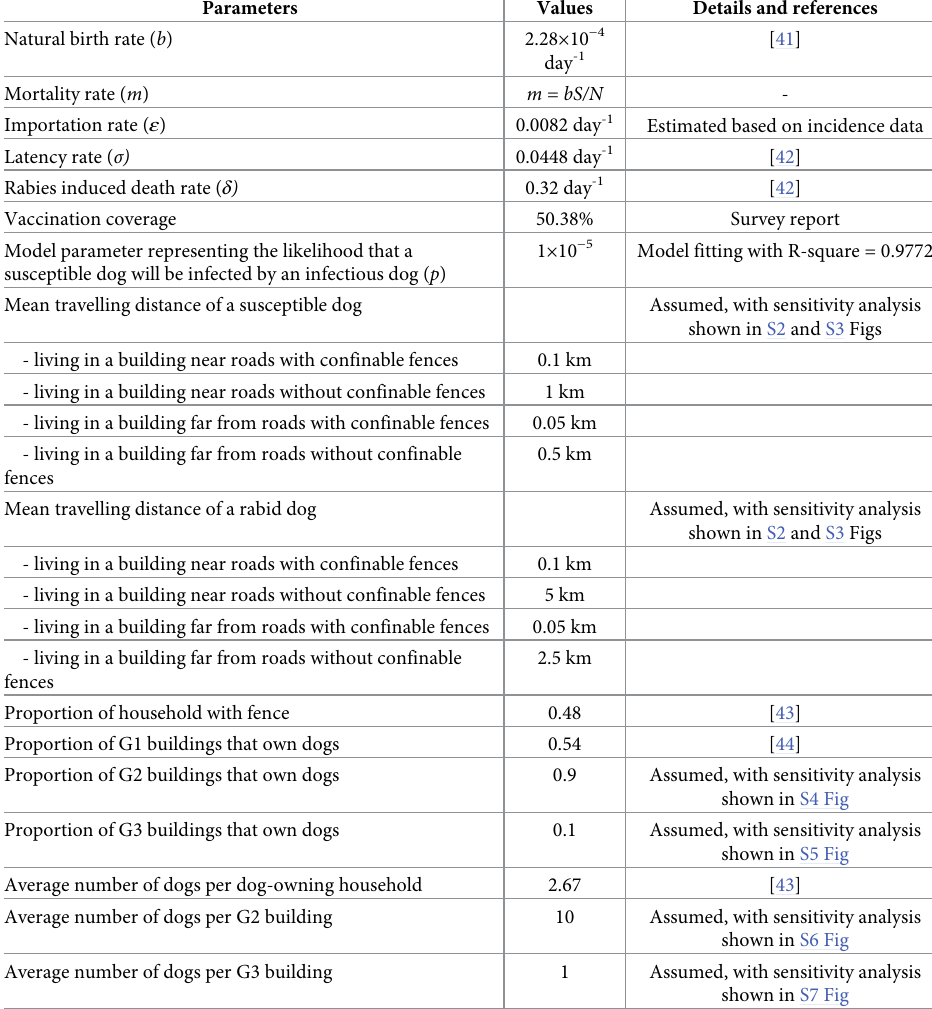
Table 1. Parameters and the baseline values used in the rabies transmission